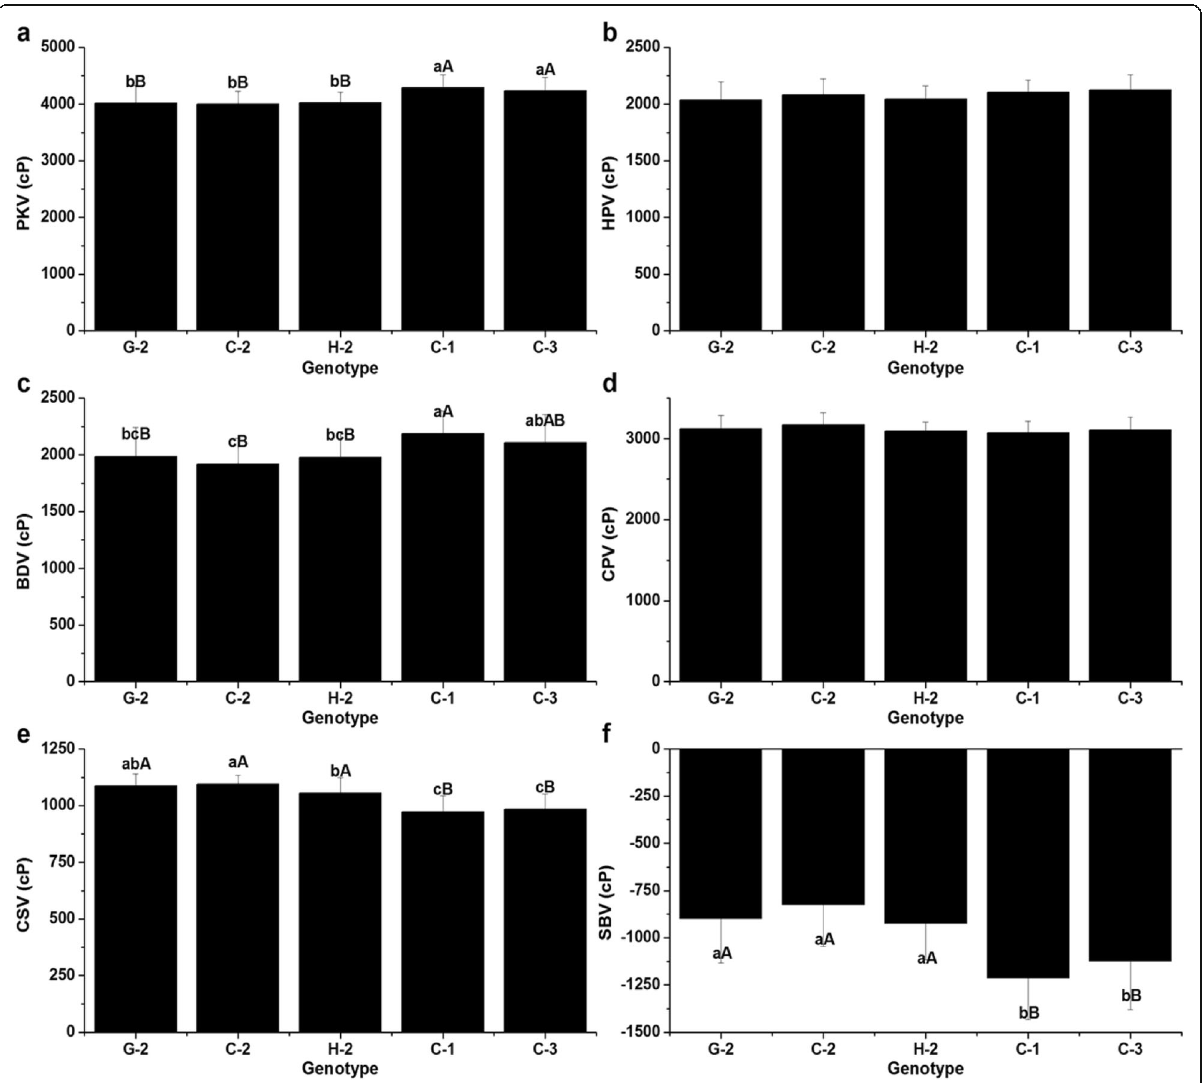
Fig. 5 Comparison of RVA profile characteristics for different combinations of SSIV-2 × PUL . a Peak viscosity (PKV); b Hot paste viscosity (HPV); c Breakdown viscosity (BDV); d Cool paste viscosity (CPV); e Consistence viscosity (CSV); f Setback viscosity (SBV); Each column represents the mean ± standard deviation. Type G, C and H represent homozygous for GZ63S, CG173R and heterozygote in SSIV-2 locus, respectively; Type 1, 2 and 3 indicate homozygous for GZ63S, CG173R and heterozygote in PUL locus, respectively; Lowercase and capital letters above column denote significant at 0.05 and 0.01